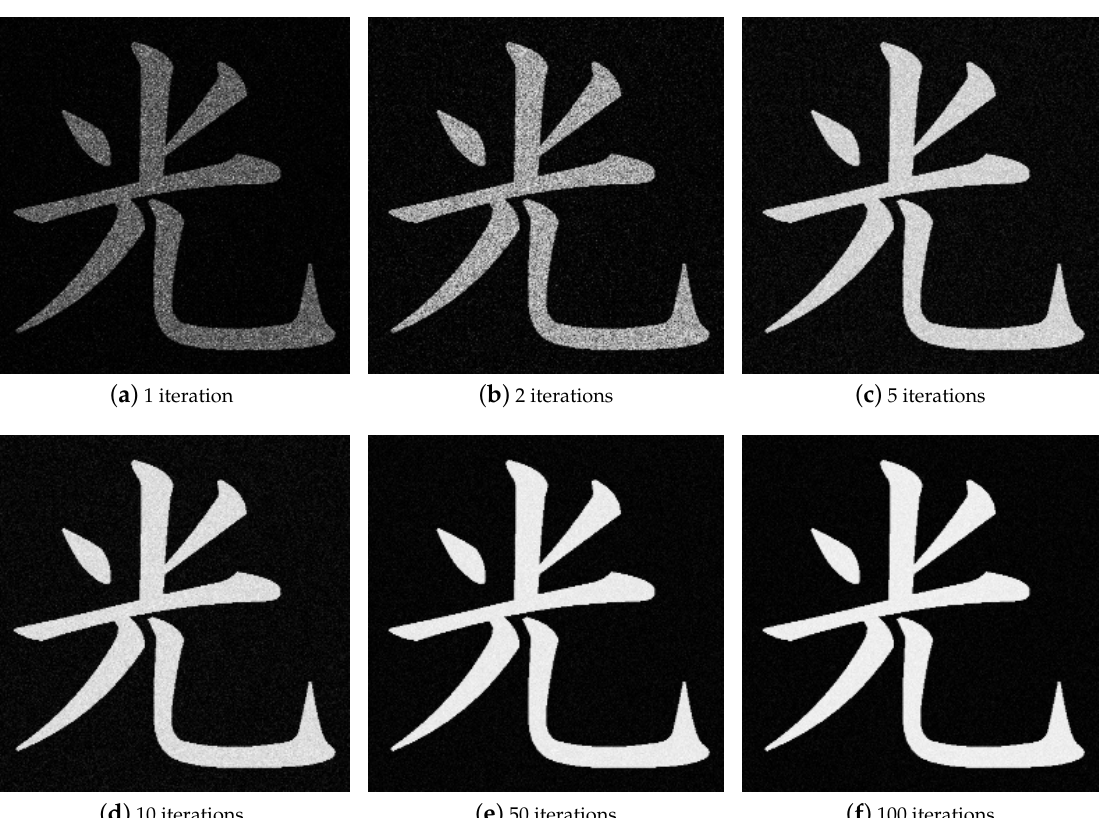
Figure 4. Reconstructed images obtained by the proposed algorithm after ( a ) 1, ( b ) 2, ( c ) 5, ( d ) 10, ( e ) 50, and ( f ) 100